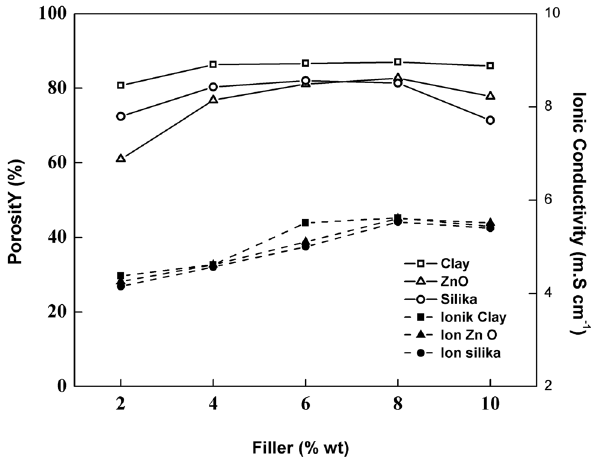
Figure 3: Porosity ( % ) and ionic conductivity ( mS cm − 1 ) of PVDF membrane with various types of fi ller.